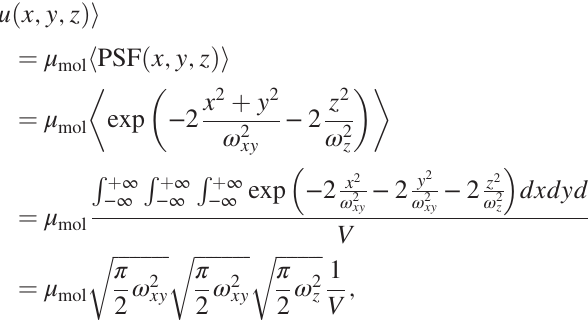
FIG. 19. Estimation of the diffusion coefficient and molecule photon emission rate for 5-TAMRA dyes. (a) Experimental intensity trace (binned at 10 μ s) with concentration 20 nM of 5-TAMRA dye molecules. A background photon emission rate of 300 photons = s is known from calibration. (b) Analyzed portion of the trace containing ≈ 8000 photon arrivals. (c) Posterior probability distributions and the value (red dashed line) of molecule photon emission rate determined by the photon count- ing histogram (PCH) method on the entire trace [59]. (d) Similarly to Fig. 1, we compare our method ’ s diffusion-coefficient estimate (green dots) to FCS (blue asterisk) as a function of the number of photons used in the analysis. Since by 1 . 5 × 10 4 photon arrivals our method has converged, we avoid analyzing larger traces. The red dashed line is the FCS estimate obtained from the entire, 10-min, trace containing ≈ 6 × 10 6 photon